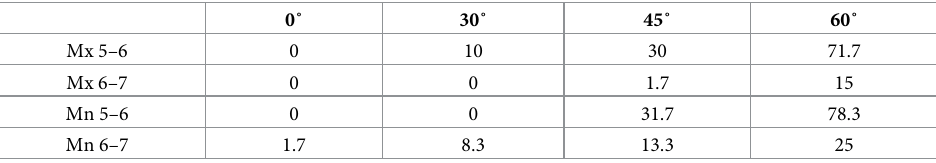
Table 4. Rates of miniscrew–root distance > 2 mm (unit: